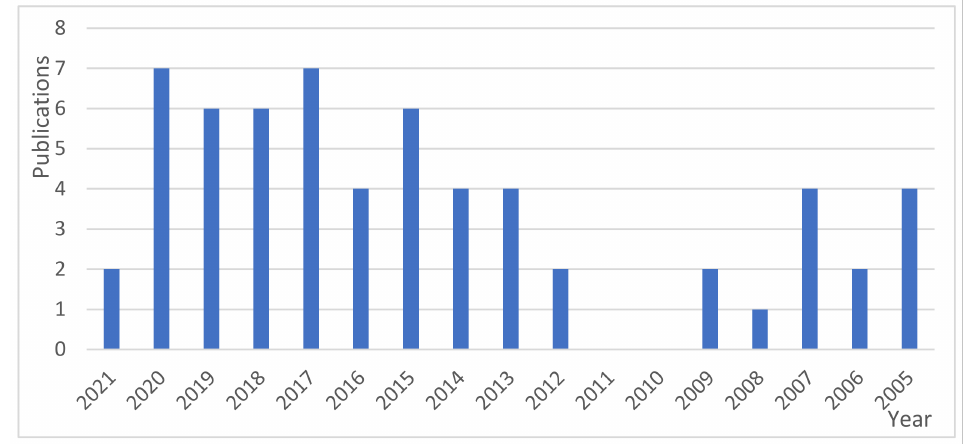
Figure 2. Publications in the last few years for “polymer composites” + biorefineries.